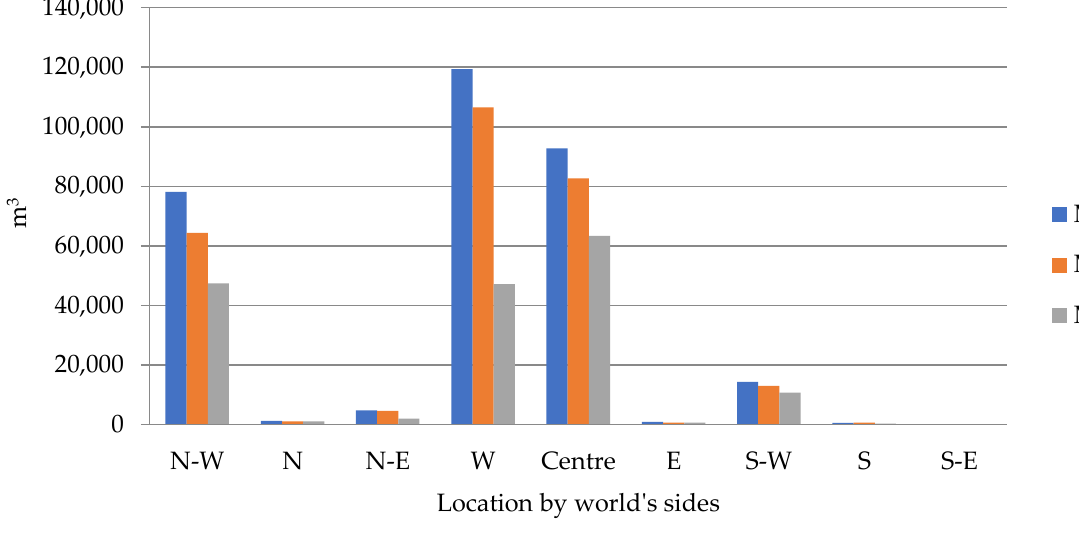
Figure 6. The amount of M1 small-sized pole wood harvested in Poland between 2018 and 2020. Own elaboration based on the available data.